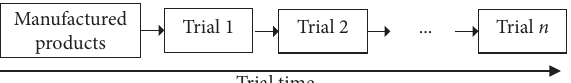
Figure 1: Flowchart of failure trial process in industry.